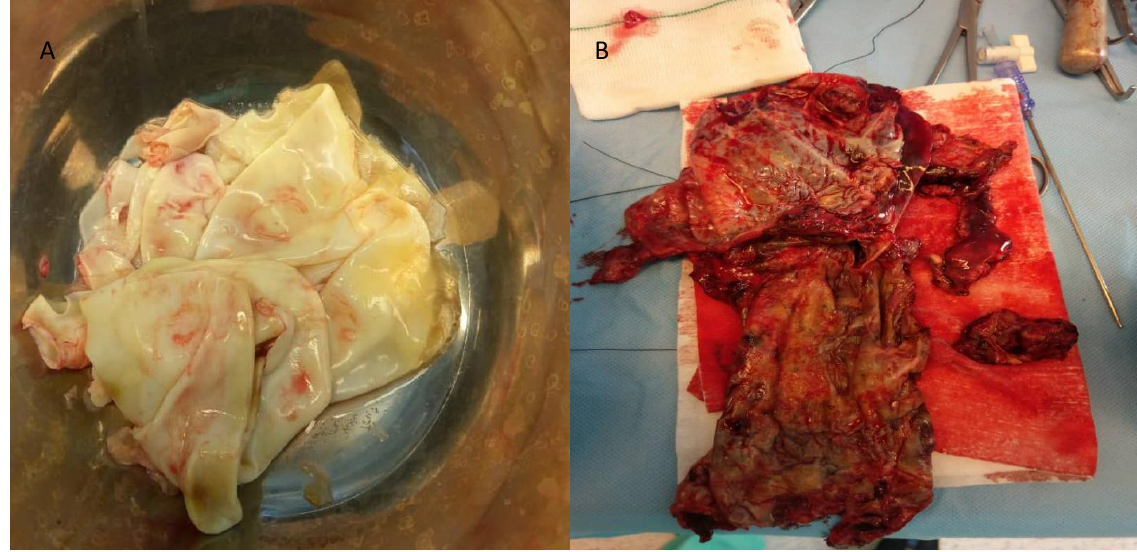
Figure 2 (A, B) : Membrane discharged and removed the cystic fibrosis (PRESIS)